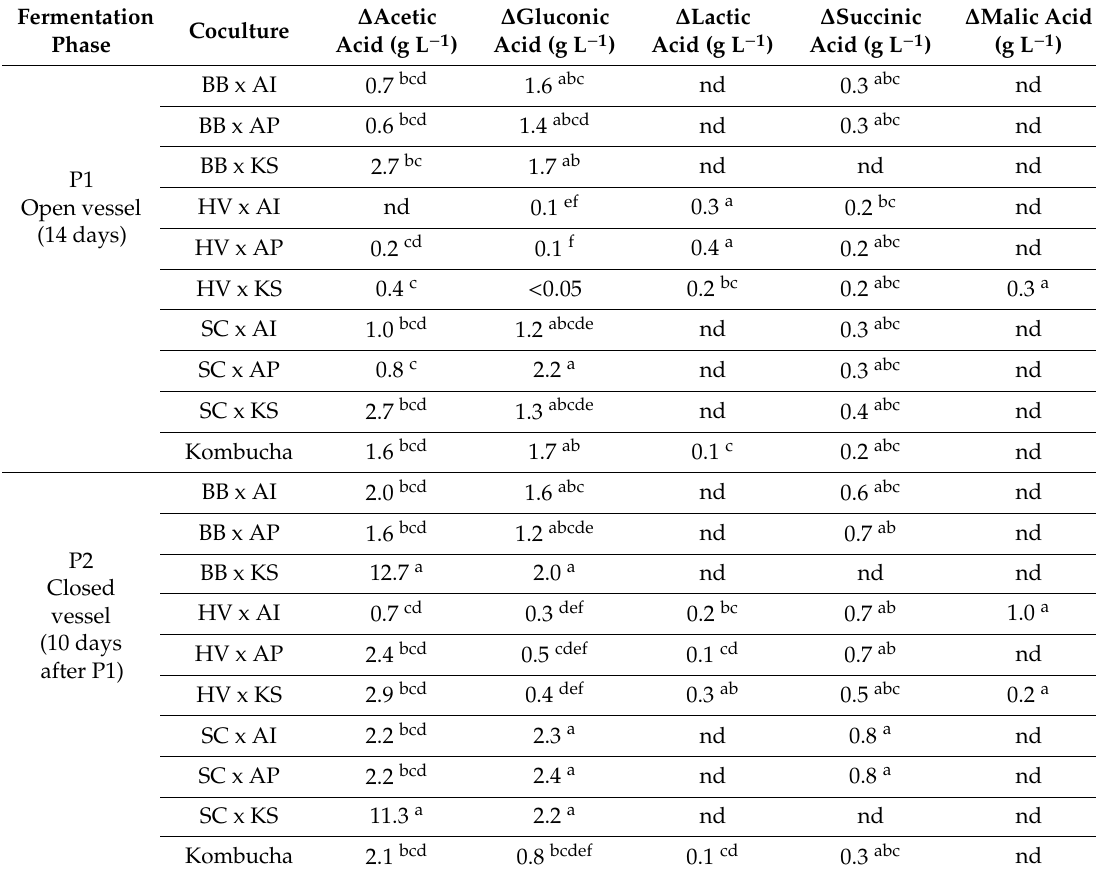
Table 3. Di ff erence in the organic acid content of samples between day 0 (after inoculation) and the end point (14 days for pure cultures, 14 days in an open vessel for P1, and 10 days in a closed vessel following P1 for